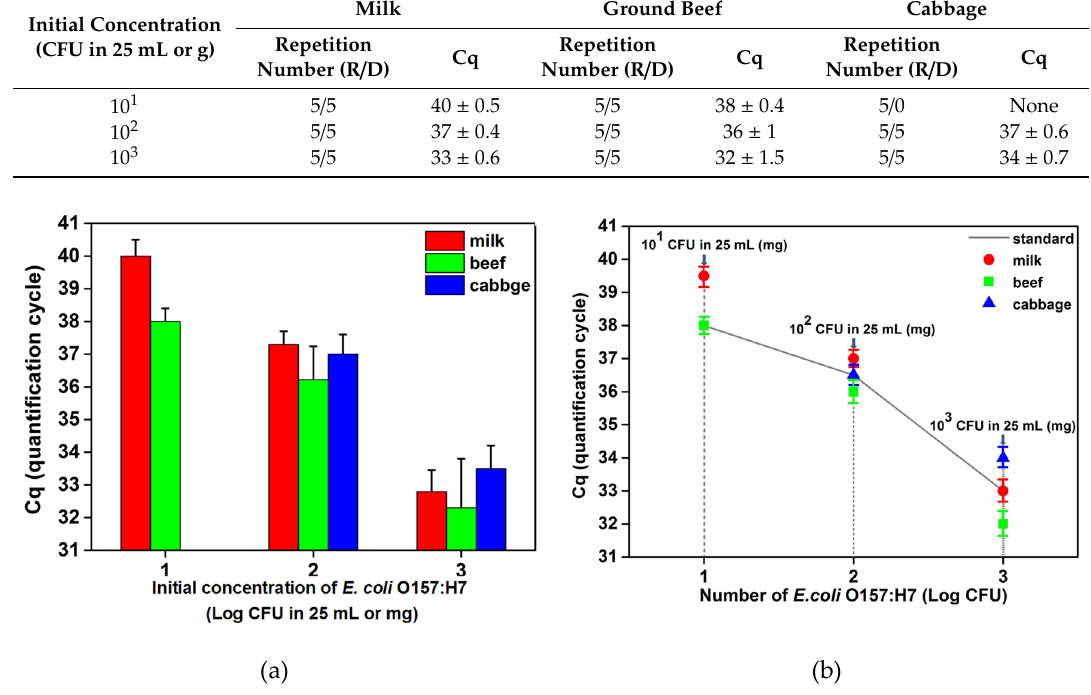
Figure 4. Detection of E. coli O157:H7 in milk, ground beef, and cabbage using the automated IMS device and analysis of the recovered bacteria by real-time PCR. ( a ) The bars indicate quantification of E. coli O157:H7 by real-time PCR for various initial concentrations of bacteria (10 1 –10 3 CFU) in foods (25 mL or mg). Error bars represent standard deviation. ( b ) The average Cq values are indicated with dots, and the black line represents the standard curve. Error bars represent standard deviation.